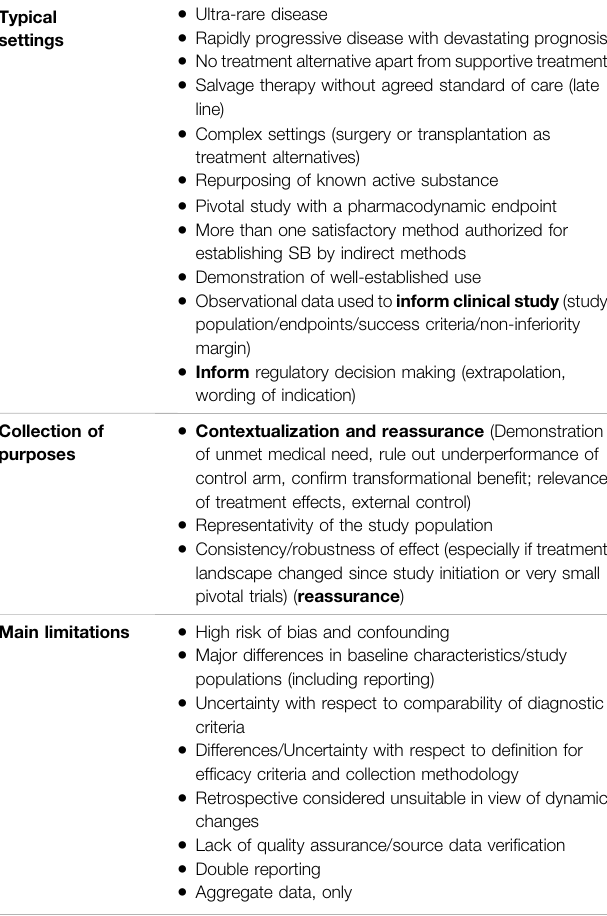
TABLE 4 | Setting, purpose, and limitations of external data. Typical